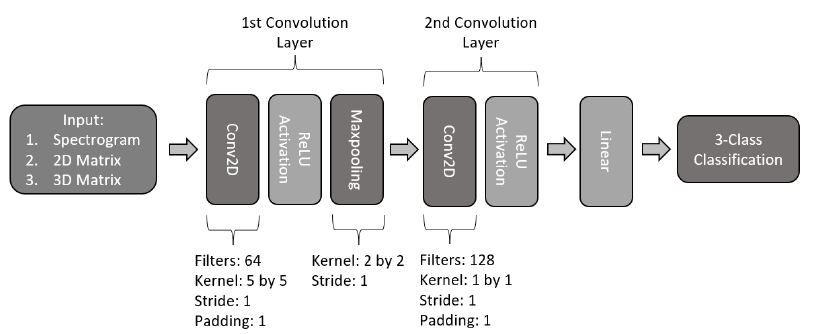
Figure 12. Architecture of two-layered CNN